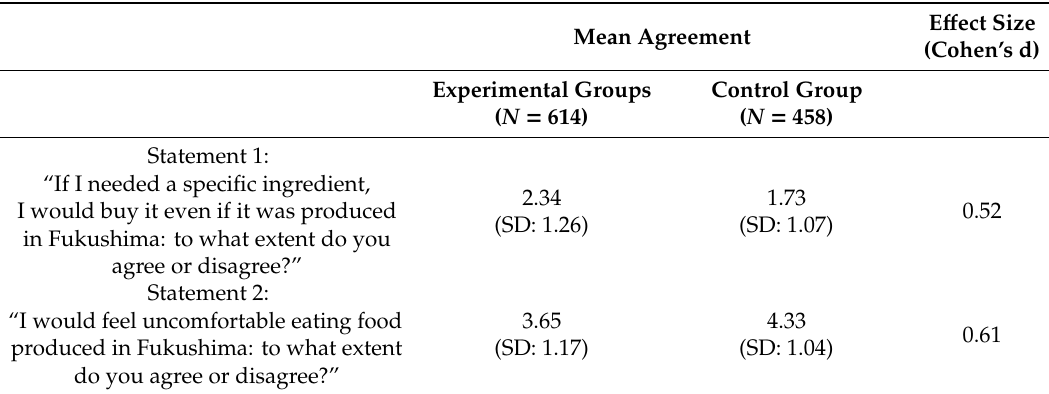
Table A1. Mean di ff erences in risk perception between experimental and control